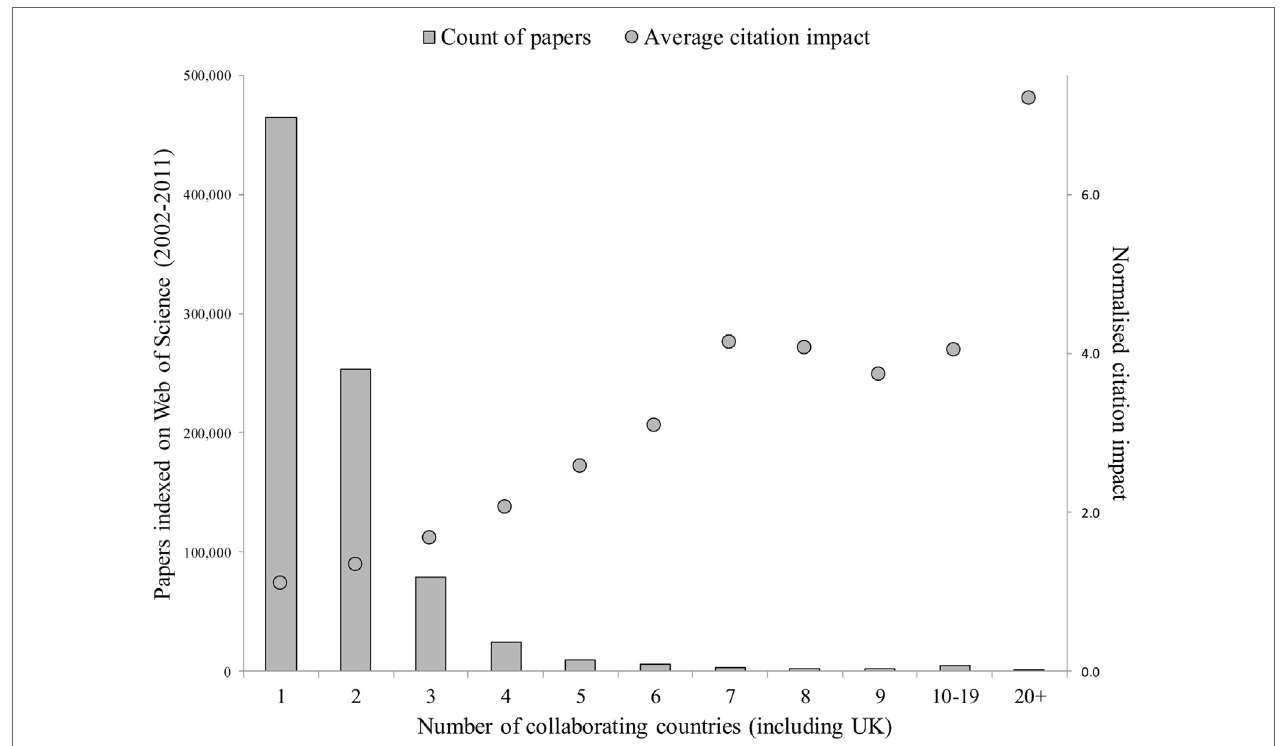
FigUre 6 | UK papers (articles and reviews) indexed on Web of Science, 2002–2011, and analyzed according to the number of unique countries (including the UK) for author addresses and the average citation impact of the set of papers for each count of countries. Impact increases to a group of seven and then levels out. Highly multinational papers ( > 20 countries) are analyzed in Figure 7